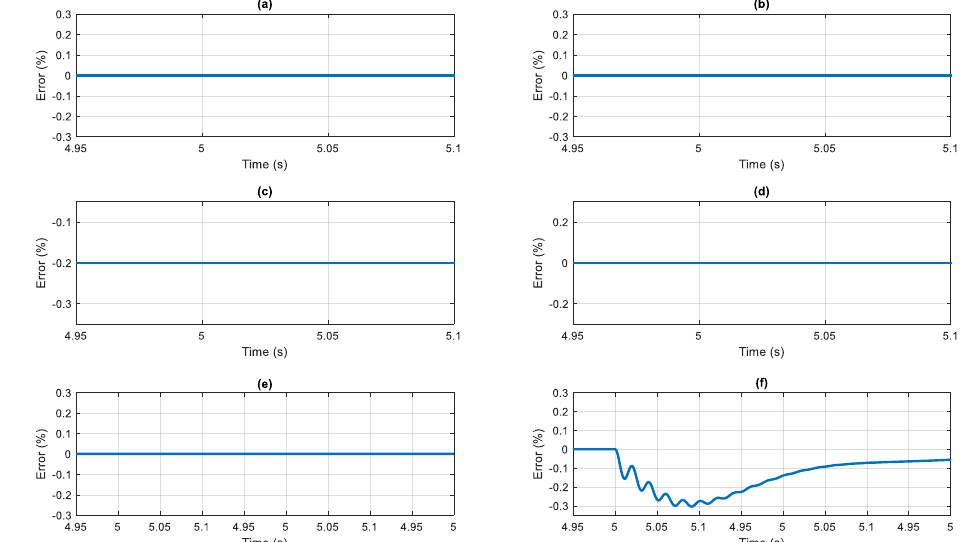
Figure 9. Validation of battery connected small-signal models: ( a ) net power command step (100 W) to net power error for PVCC, ( b ) net frequency step (0.2 rad / s) to net power error for PVCC, ( c ) net power command step (100 W) to net power error for PVCCI, ( d ) net frequency step (0.2 rad / s) to net power error for PVCCI, ( e ) net power command step (100 W) to net power error for VSM and ( f ) net frequency step (0.2 rad / s) to net power error for